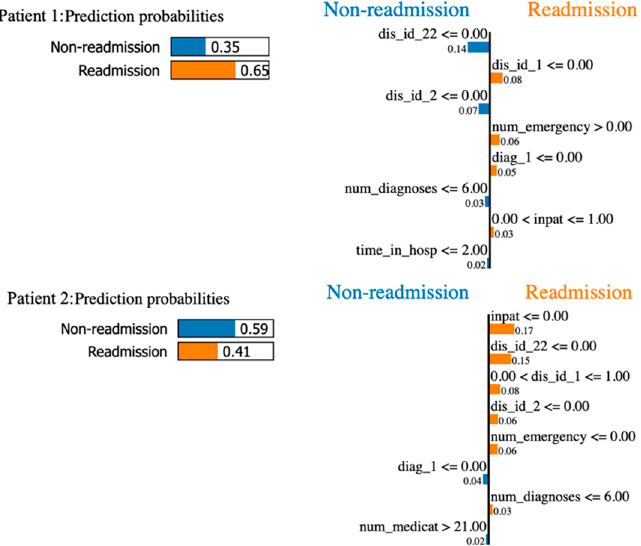
Figure 8. LIME explanation for patients. dis_id_22 , dis_id_2 , and dis_id_1 stand for Discharged/transferred to another rehab fac, including rehab units of a hospital, Discharged/transferred to another short-term hospital, and Discharged to home, respectively. num_emergency stands for the number of emergencies, diag_1 stands for the primary diagnosis (coded as the first three digits of ICD9), num_dianoses stand for the number of diagnoses, input stands for the number of inpatients, time_in_hosp stand for the time in hospital and num_medicat stands for the number of medications. The right-hand side of the figures shows the weights assigned to each feature. The colours and directions of each weight’s bars indicate which class they contributed to the prediction.